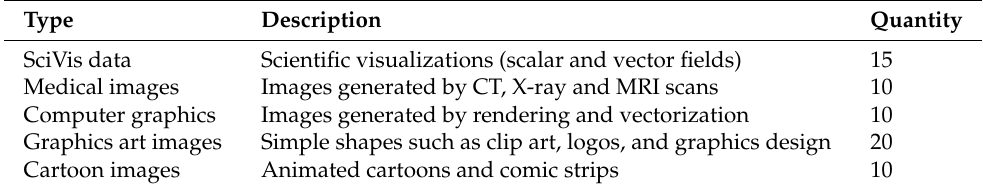
Table 1. The benchmark of five image types (available at [41]) used throughout this work for evaluating SDMD. Type Description Quantity SciVis data Scientific visualizations (scalar and vector fields) 15 Medical images Images generated by CT, X-ray and MRI scans 10 Computer graphics Images generated by rendering and vectorization 10 Graphics art images Simple shapes such as clip art, logos, and graphics design 20 Cartoon images Animated cartoons and comic